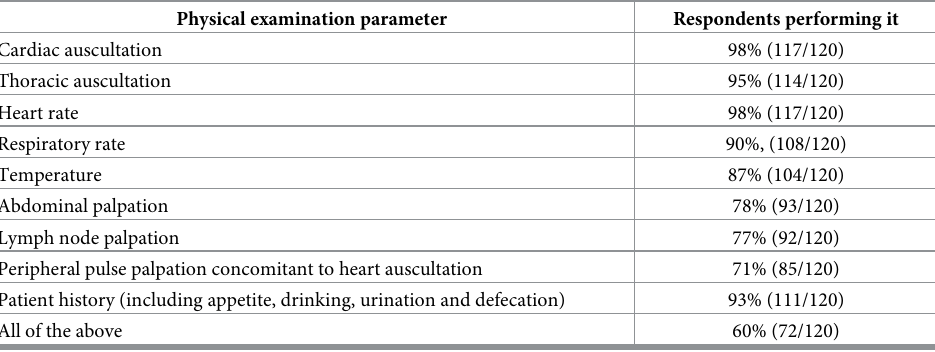
Table 3. Physical examination parameters evaluated by English-speaking veterinarian respondents (n =